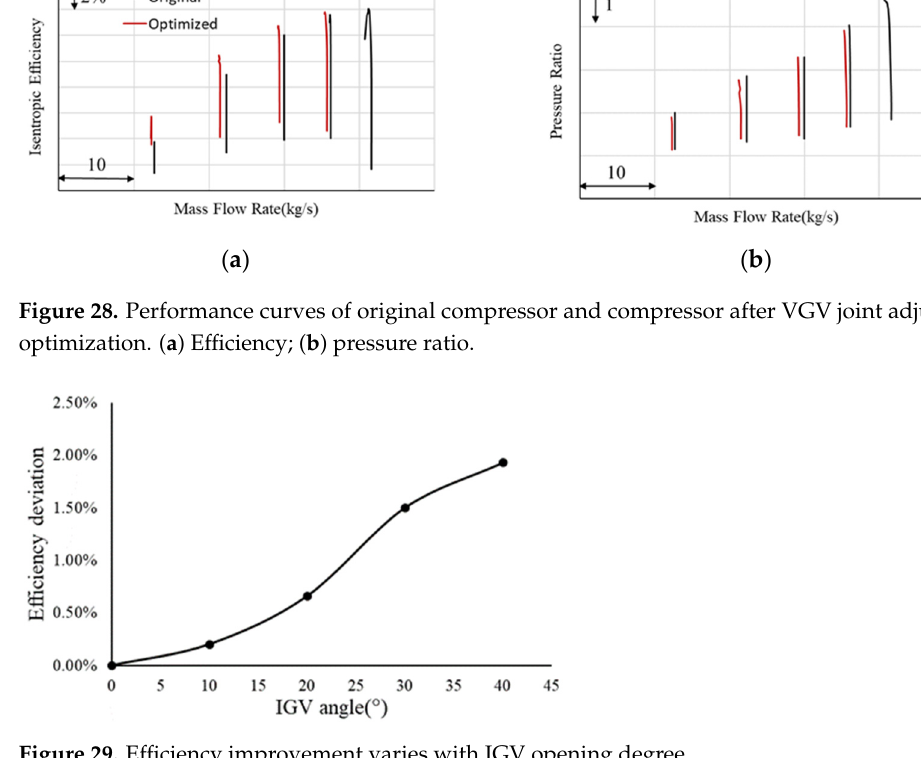
Figure 29. Efficiency improvement varies with IGV opening